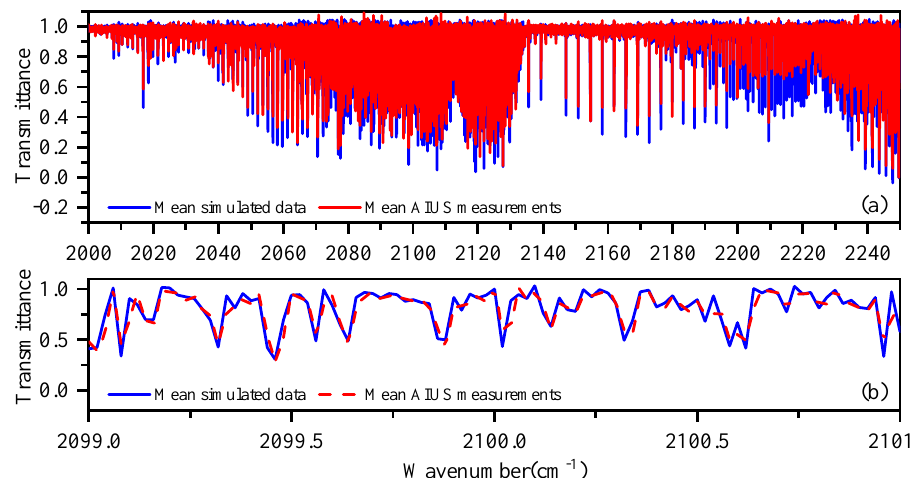
Figure A3. Mean transmittance of AIUS measurements and simulations in 2000–2250 cm − 1 at 40